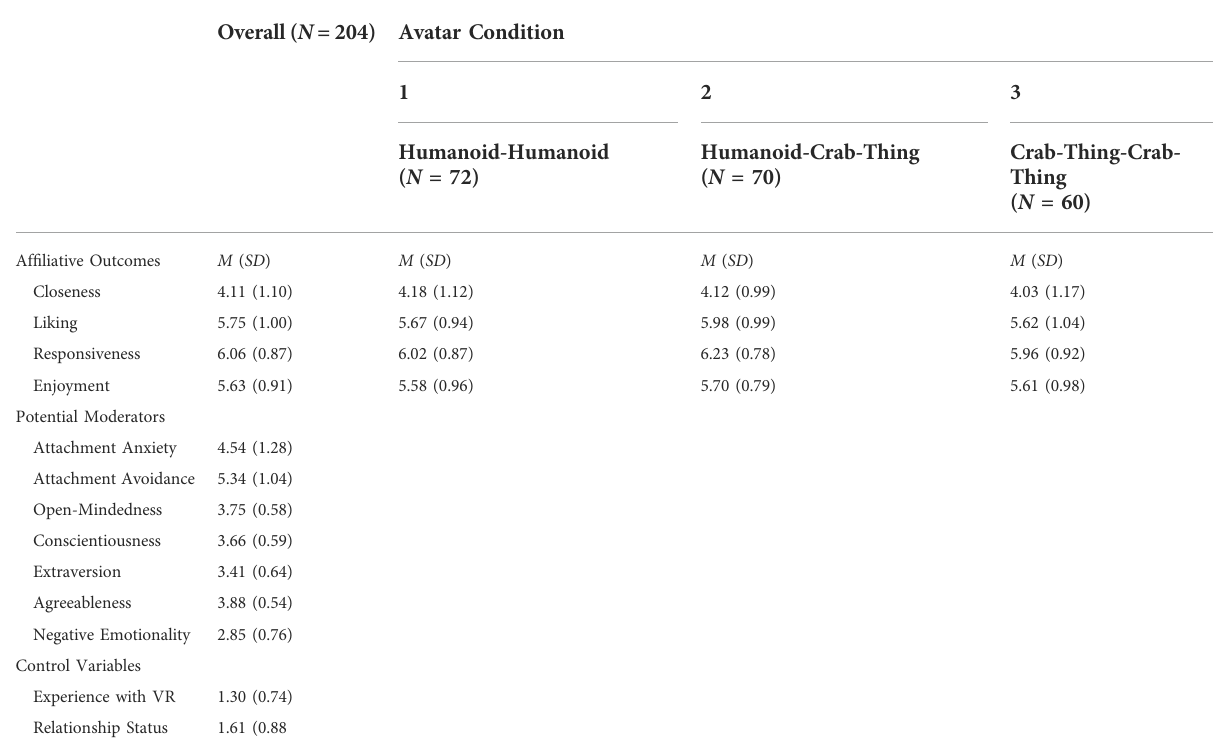
TABLE 1 Means and Standard Deviations, Overall and by Avatar